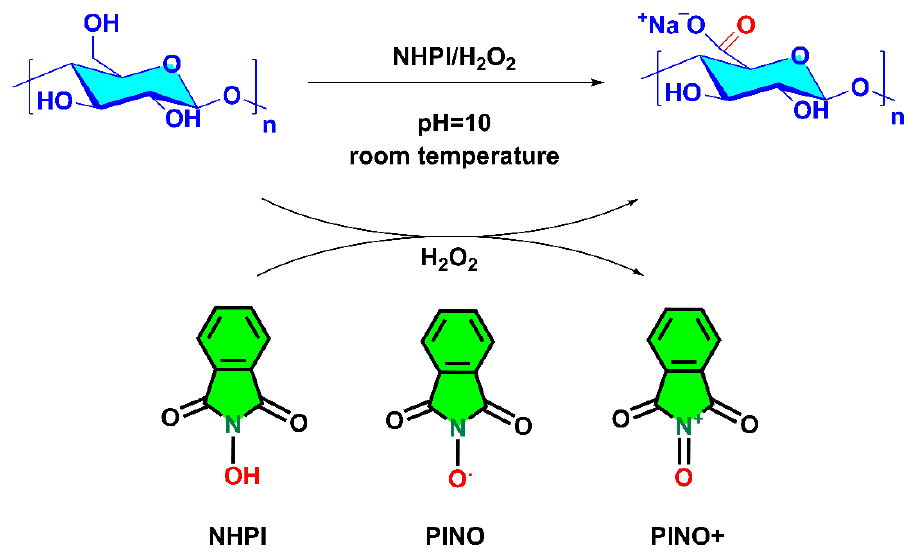
Figure 3. Pullulan oxidation scheme mediated by NHPI/H 2 O 2 at pH = 10. Table 1. Amount of negatively charged groups (COO − ), reaction time, and yield for oxidized pullulan (PO), at different reaction times and pH = 10. * Oxidation in the presence of H 2 O 2 , without NHPI in the same